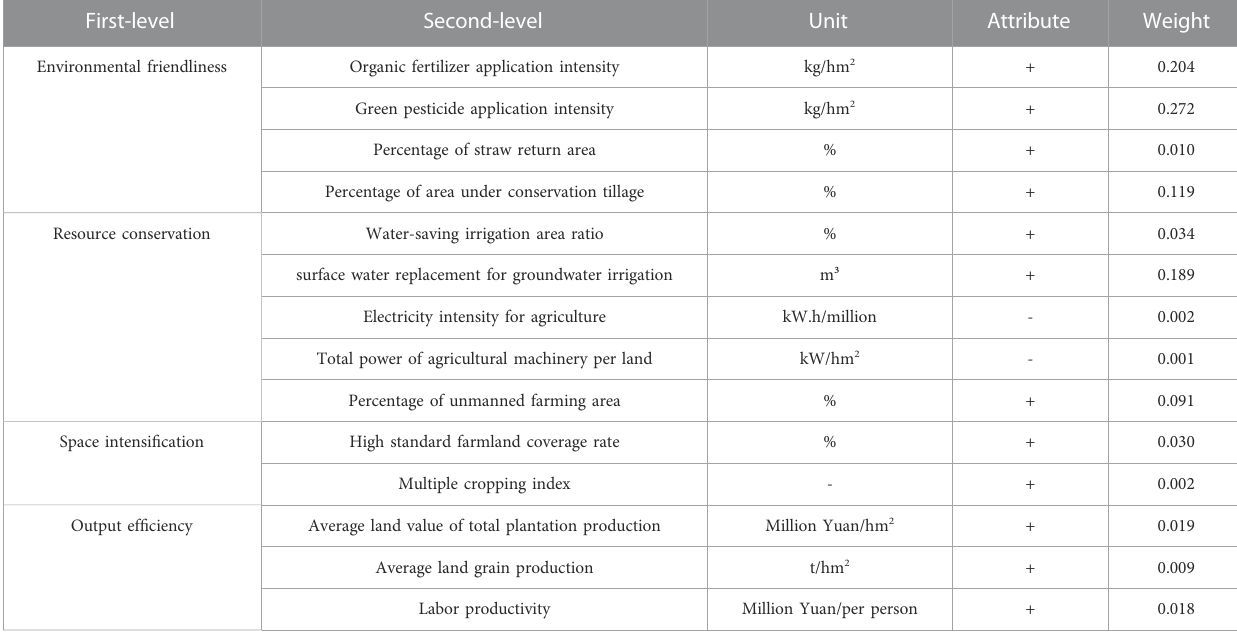
TABLE 1 Construction of the GUL-CL in the Heilongjiang reclamation area